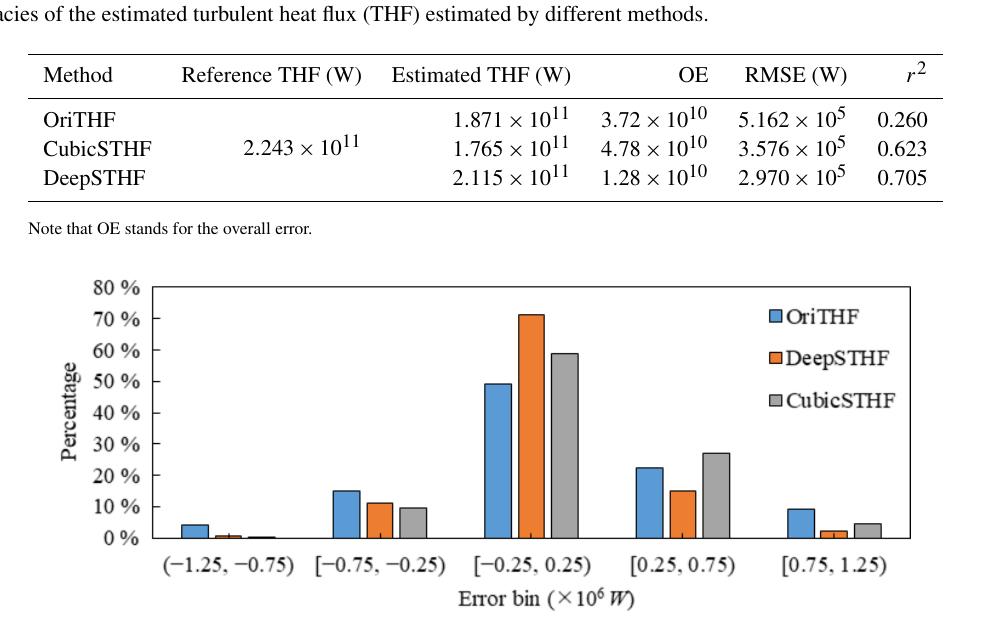
Figure 11. Error distribution of the THF estimated by three different